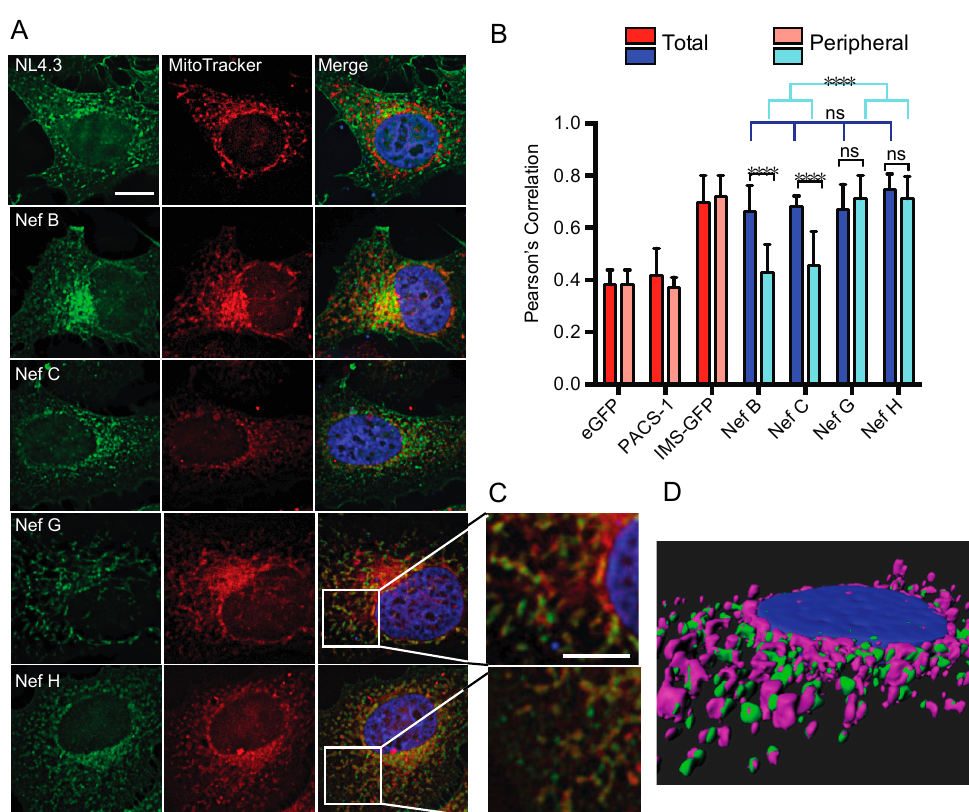
Figure 7. Nef from HIV-1 group-M reference strains G (F1.93.HH8793) and H (BE.93.VI997) colocalize with MitoTracker ® . ( A ) CD4 HeLa cells were transfected with various pN1 Nef–eGFP fusion plasmids encoding Nef from different HIV-1 subtype reference strains. Twenty-four hours post transfection, cells were stained with 100-nM MitoTracker ® DeepRed for 15 min, then fixed in 4% paraformaldehyde, and imaged on a Leica DMI6000 widefield microscope on the 100 × objective; scale bar = 10 µ m, green = Nef–eGFP, red = MitoTracker ® . ( B ) Total and peripheral cellular colocalization of Nef–eGFP and MitoTracker ® are shown. Images were deconvolved, and colocalization analysis was completed using the Pearson’s Correlation with the JaCoP Image J plugin. Mean (+/ − SD) Pearson’s correlations of Nef and MitoTracker ® DeepRed colocalization are illustrated from three independent experiments. Red bars = controls; blue bars = experimental samples. ( C ) Right panel insets represent a 4 × magnified image of the area selected. Scale bar = 5 µ m. ( D ) A sample surface modeling of the Nef G–MitoTracker ® colocalization was generated via a three-dimensional (3D) rendering using the Imaris softeare (version 7.0); green = Nef, pink = mitochondria (ns: non-significant; **** p ≤ 0.0001; SD: standard deviation).